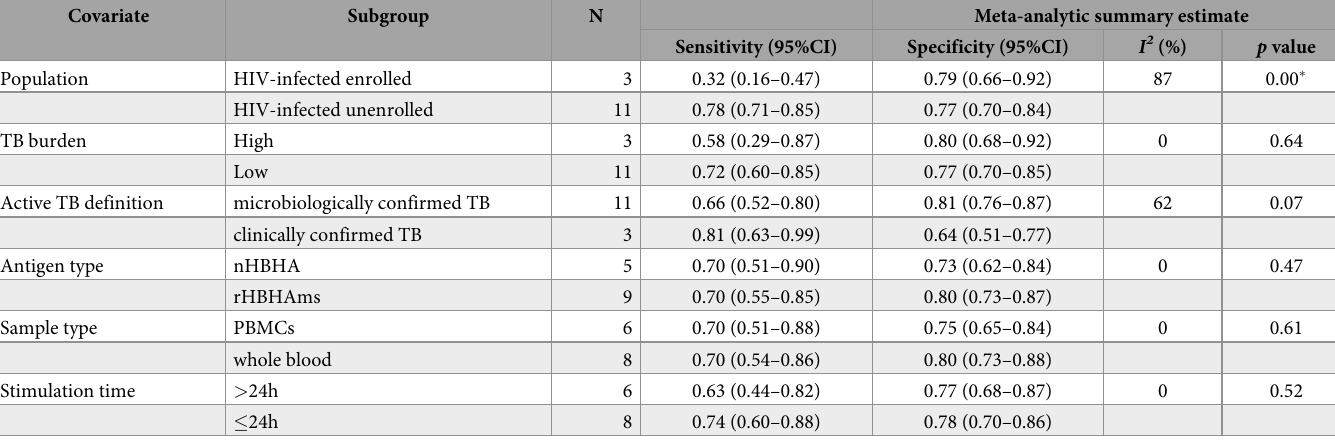
Table 3. Subgroup analysis of the HBHA-IGRA for discrimination of the LTBI and active TB.